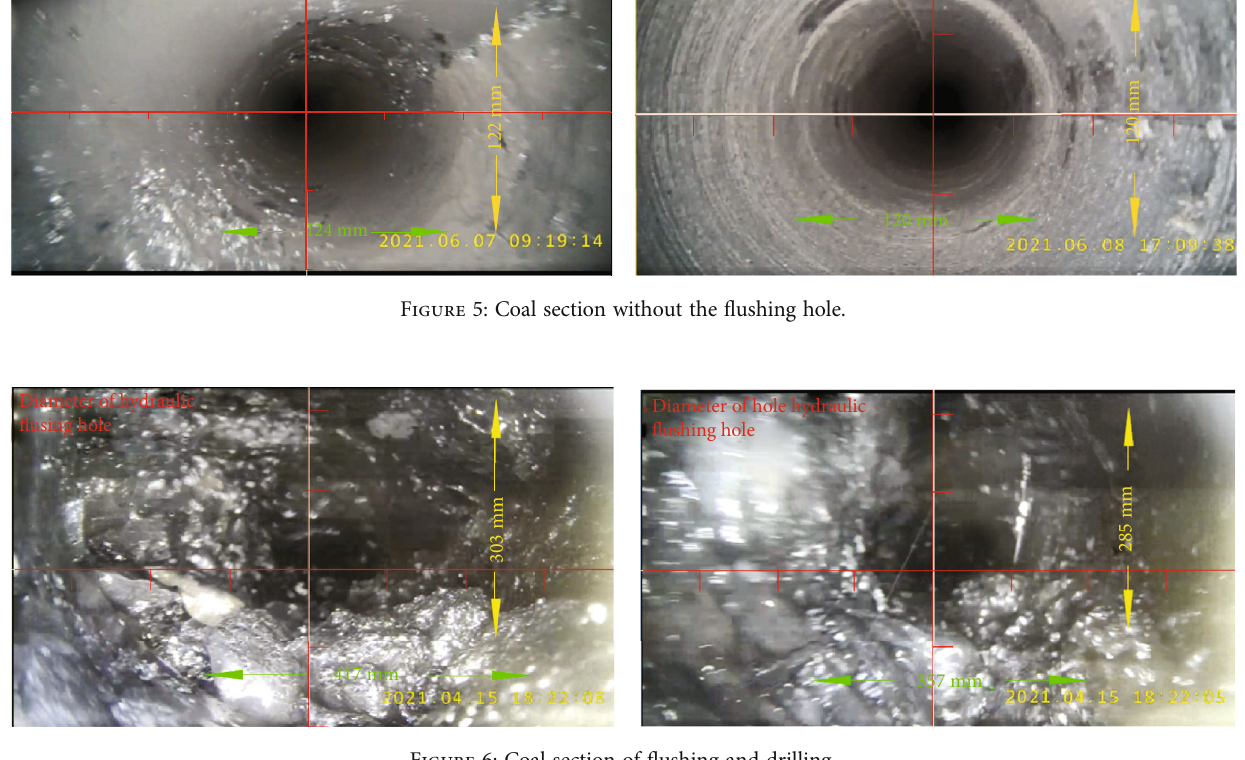
Figure 6: Coal section of fl ushing and drilling.